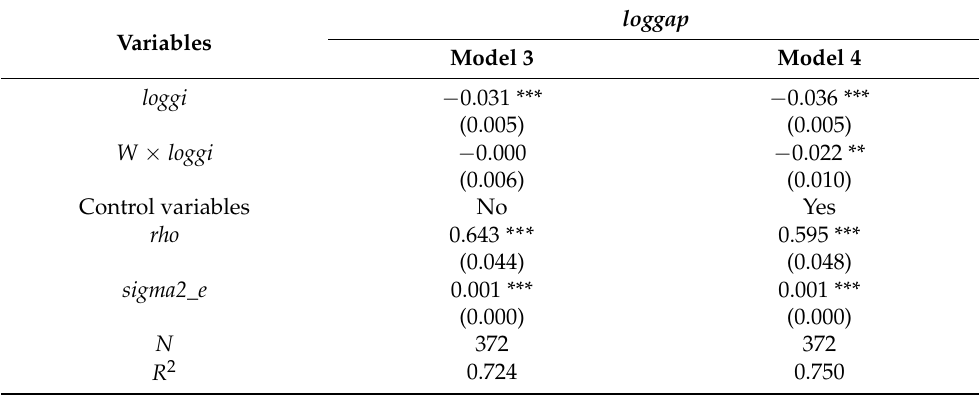
Table 8. Robustness